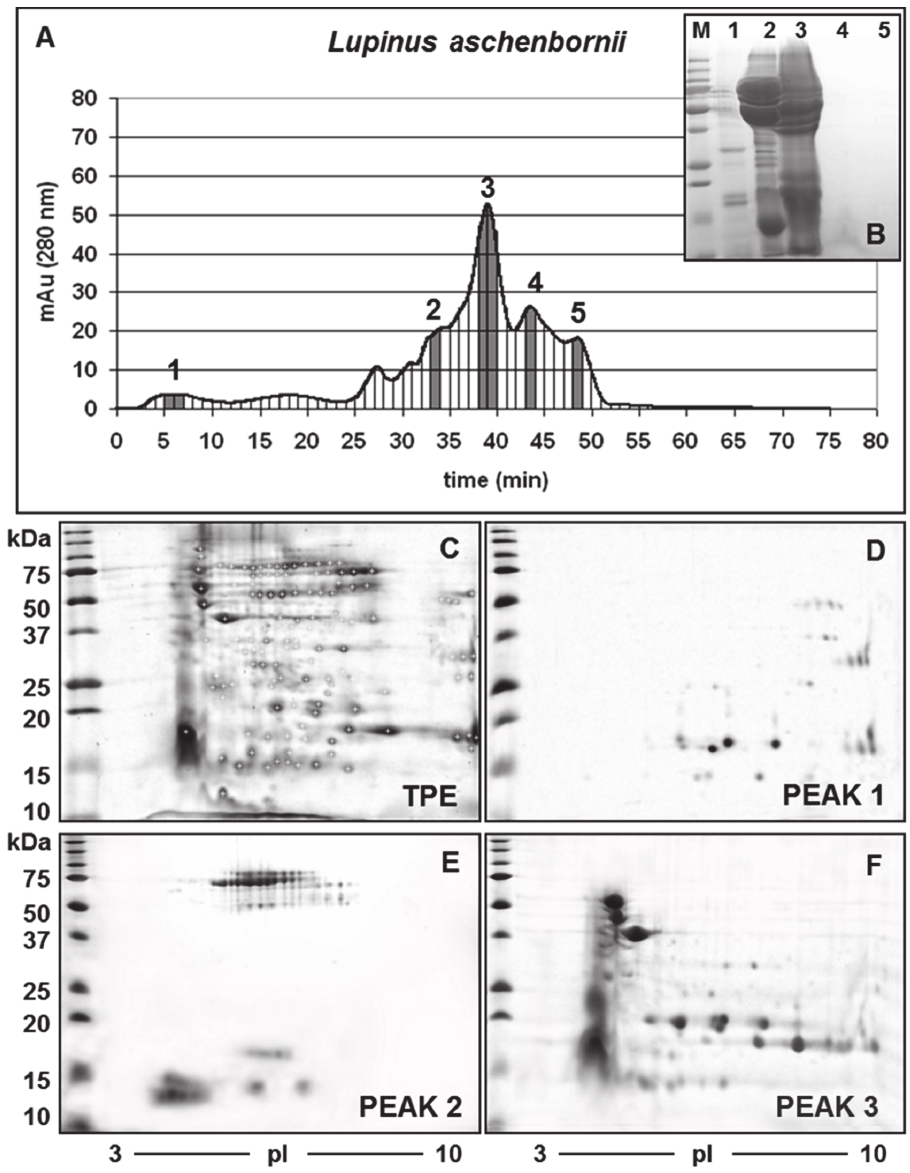
Figure 3. Electrophoretic gels of proteins of L. aschenbornii . ( A ) HPLC chromatogram of the total protein extract (TPE) on a Mono Q column. ( B ) SDS ‐ PAGE of the preparative HPLC collected frac ‐ tions. ( C ) Proteome reference map of reduced TPE, where in total 126 spots were detected. ( D ) Two ‐ dimensional map of purified γ‐ conglutin. ( E ) Two ‐ dimensional map of purified β‐ conglutin. ( F ) Two ‐ dimensional map of purified α‐ conglutin. The standard marker (Precision Plus Protein) is in ‐ dicated in kDa on the left.